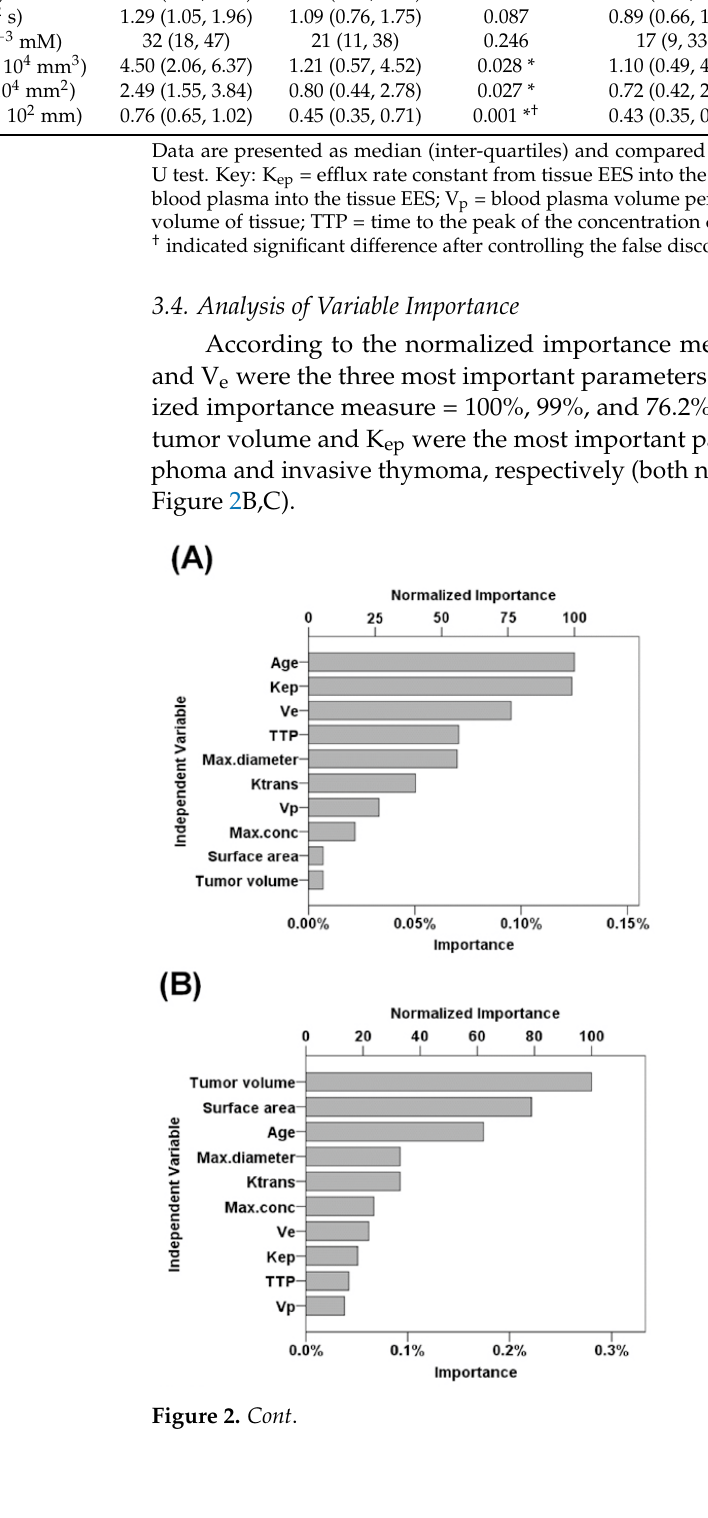
Figure 2. Performance of predictive parameters using variable importance analysis. ( A ) Parameters for predicting PMT subtypes. ( B ) Parameters for predicting Hodgkin lymphoma. ( C ) Parameters for predicting invasive thymoma. Abbreviations: EES = extravascular extracellular space; K trans = efflux rate constant from blood plasma into the tissue EES; K ep = the efflux rate constant from tissue EES into the blood plasma; V e = EES volume per unit of tissue; V p = blood plasma volume per unit volume of tissue; TTP = time to peak of the concentration curve.